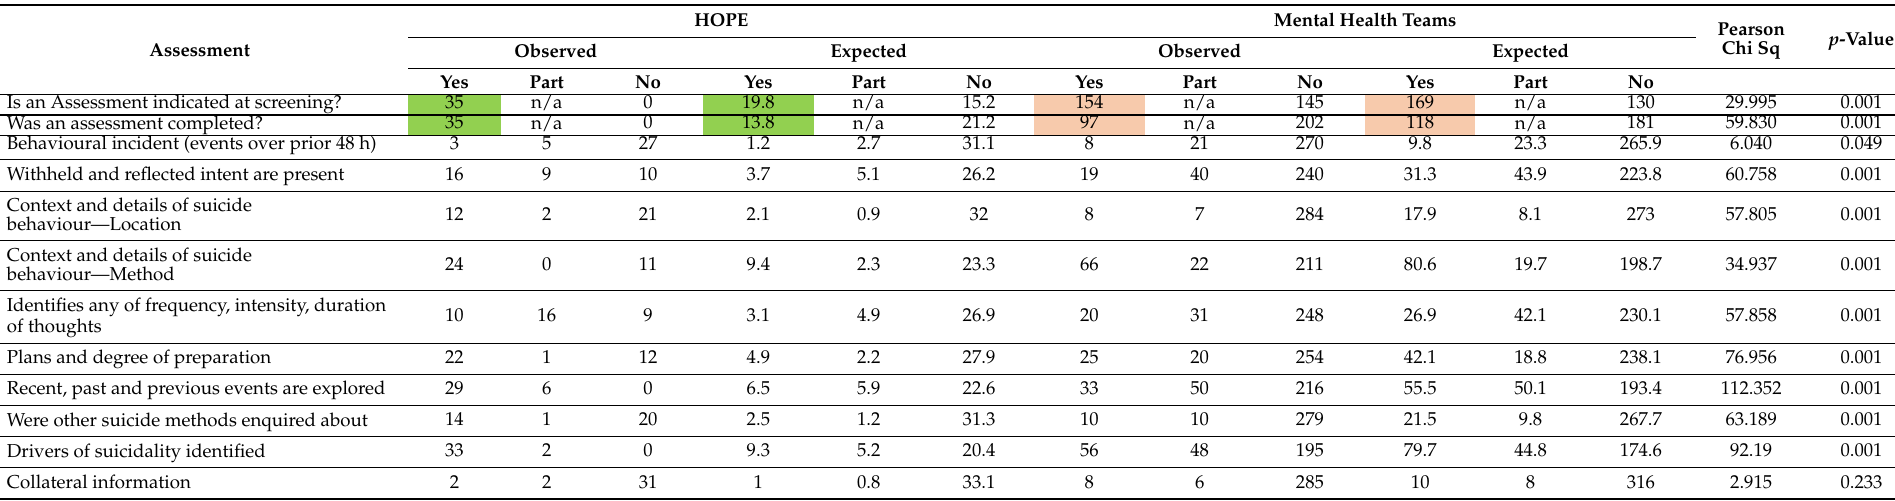
Table 2. Assessment. Key—Green: above expected and Orange: below